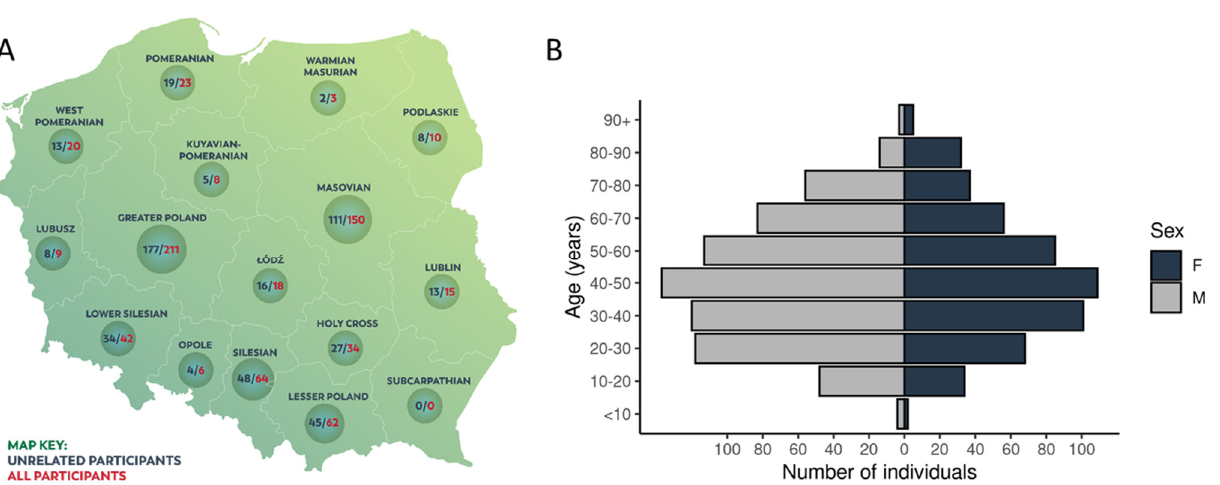
Figure 1. Polish cohort characteristics. ( A ) Sample collection locations for 675 individuals enrolled in “The Thousand Polish Genomes Project” (related and unrelated ones) in respect to Polish voivodeships. The figure presents a subset of samples with location data available. ( B ) Age distribution of 1076 unrelated study participants.